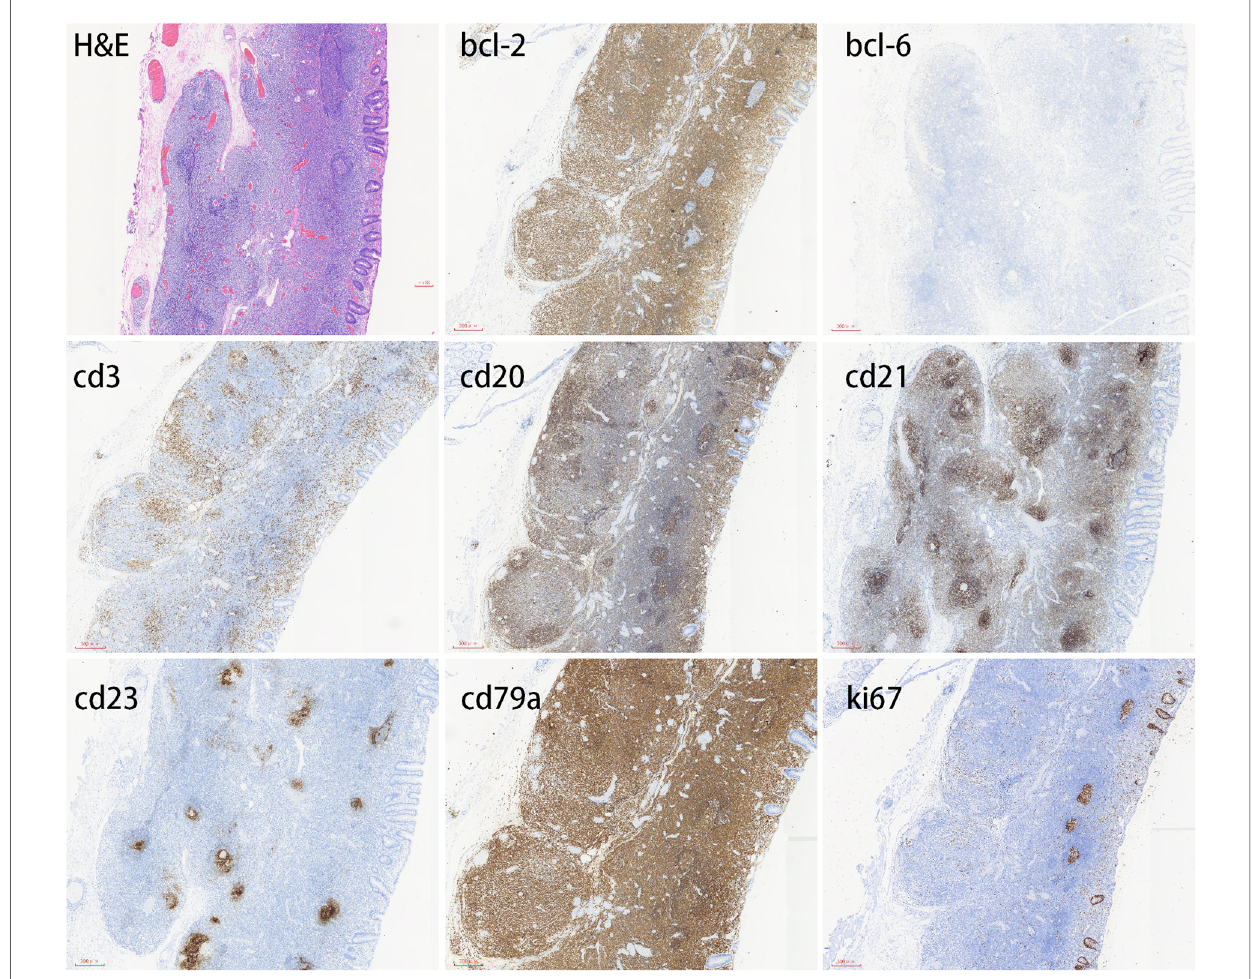
FIGURE 2 Immunohistochemical pro fi le of colonic mucosa – associated lymphoid tissue lymphoma. MALT lymphoma is positive for CD20 and CD79a but negative for CD3 and Bcl-6. CD21 lymphocytes and FDC are positive, and CD23 FDC is also positive. Bcl-2 is usually positive. The Ki-67 proliferation index is typically